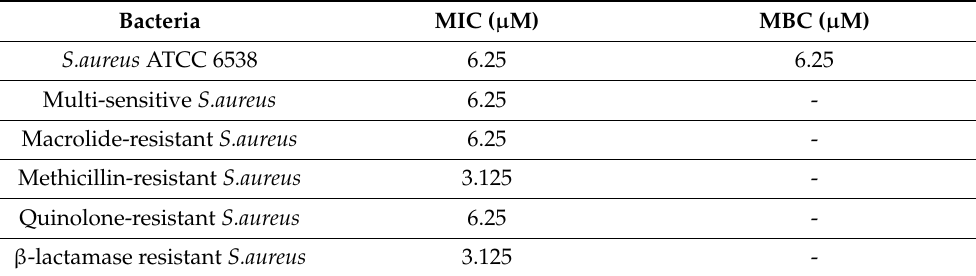
Table 1. Summary of MICs and MBCs evaluated for Hylin-a1 against different S. aureus strains.